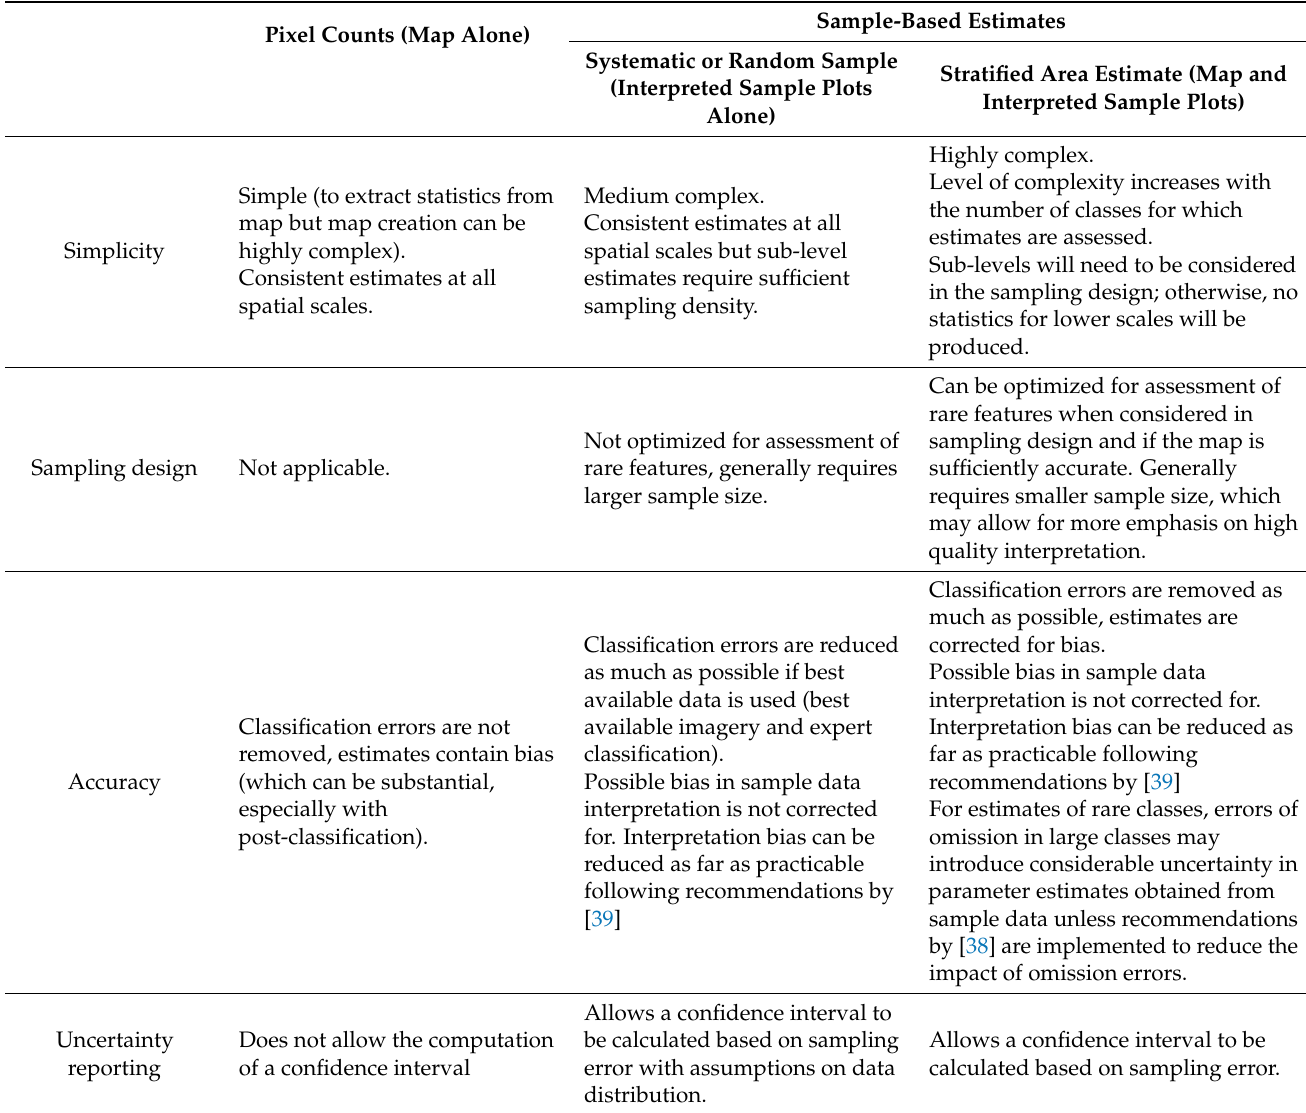
Table 1. Main characteristics of area estimates based on pixel counts and two sample-based